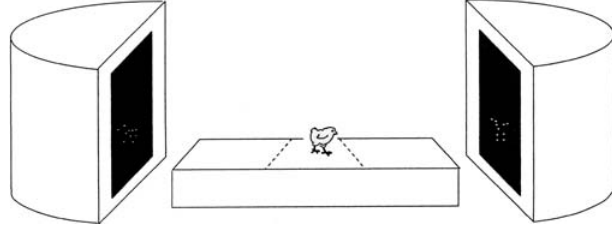
Figure 2. Schematic Representation of the Test Apparatus DOI: 10.1371/journal.pbio.0030208.g002 PLoS Biology |